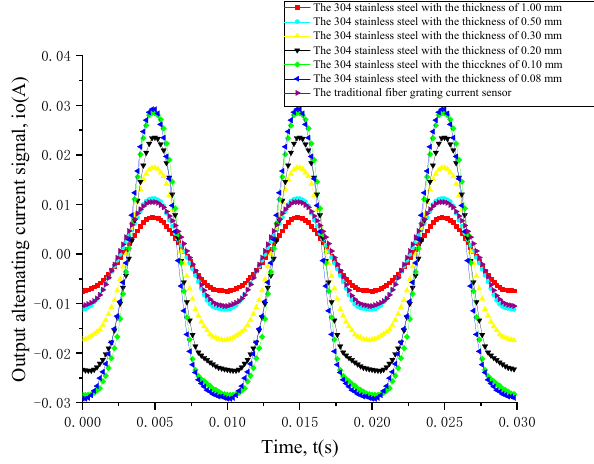
Figure 6. The experimental results of this sensitivity-enhanced fiber grating current sensor with different 304 stainless steel thicknesses and this traditional fiber grating current sensor together between output alternating current signal ( i o ) and time ( t ). The red curve, the light blue curve, the yellow curve, the black curve, the green curve and the blue curve show the relationship of the sensitivity-enhanced fiber grating current sensor, whose 304 stainless steel thicknesses are, respectively, 1.00, 0.50, 0.30, 0.20, 0.10 and 0.08 mm. The purple curve shows the relationship of the traditional fiber grating current sensor, in which the 304 stainless steel doesn’t exist, whose GMM in the sensor probe is the same as that of the sensitivity-enhanced fiber grating current sensor in size or other aspects.